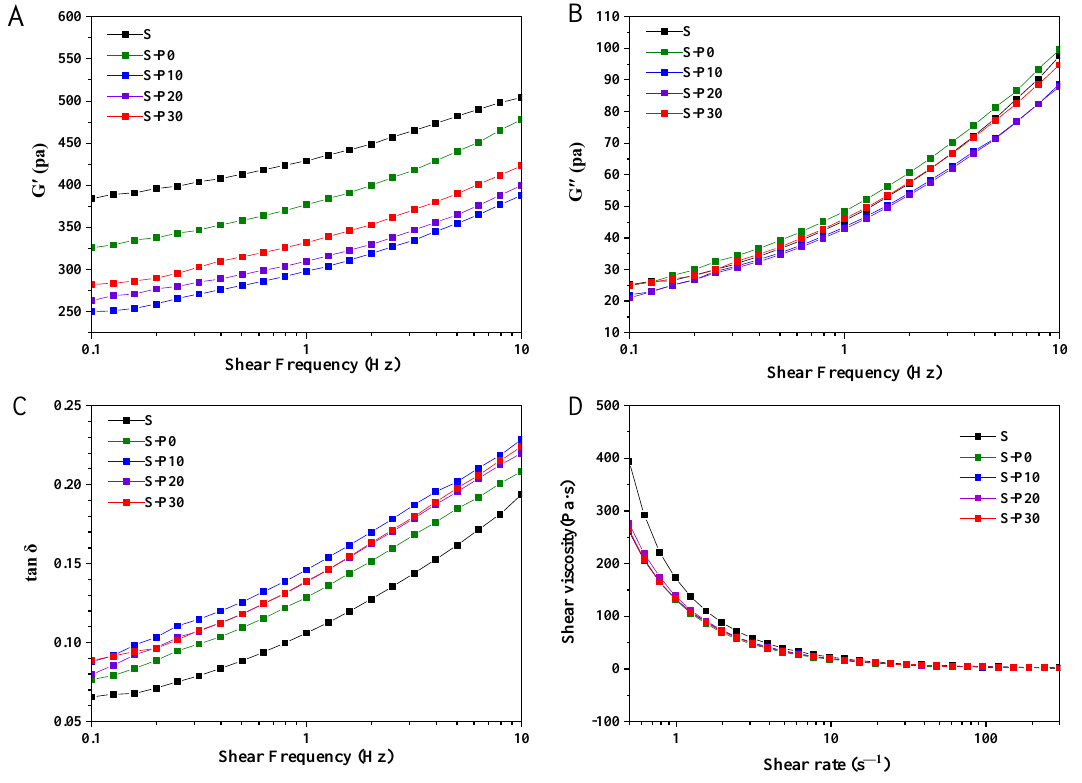
Figure 4. Dynamic rheological properties ( A – C ) and flow curves ( D ) of rice starch, and rice starch blended with protein or homogenized proteins. S, rice starch; S-P0, S-P10, S-P20 and S-P30 represented the rice starch blend with rice protein homogenized for 0, 10, 20 and 30 min, respectively. The addition of protein or homogenized proteins decreased the G′ and G″ of starch gels, and the magnitude of G′ w as greater than that of G″, thus indicating that the addition of protein or homogenized proteins decreased the viscoelasticity of the starch pastes. The viscoelasticity of starch pastes was controlled by the properties of starch (permanent junc- tion zones in the network) and its interaction with addition (temporary entanglements between additives and starch, as well as loops among additives themselves in the net- work) [40]. The interaction of proteins/homogenized proteins with starch could be facili- tated to increase the number of temporary network points, while the number of perma- nent network points that were represented by gel-forming junction zones of the starch decreased. Dynamic loss tangents (tan δ), a function of G″/G′, indicates the vis cous and elastic character of the starch pastes [41 ]. The tan δ of rice starch added proteins was ap- parently higher than that of control samples, as shown in Figure 4C. More importantly, the higher tan δ was observed in the gels with the addition of homogenized proteins.